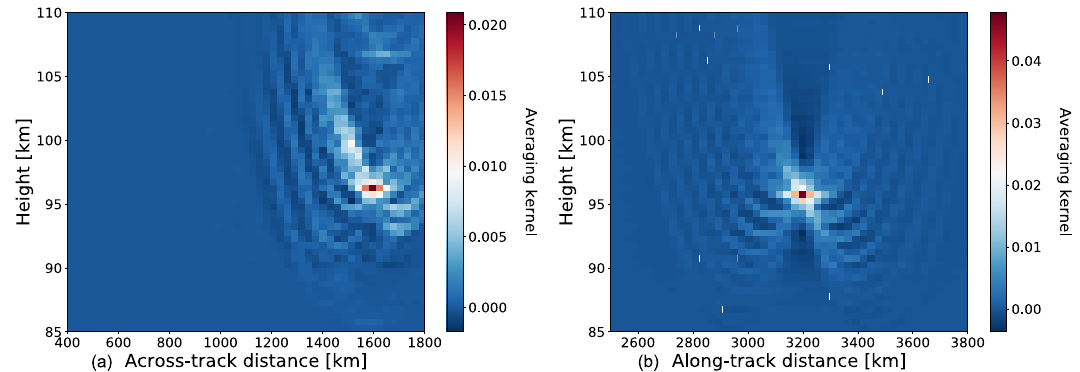
Figure 8. Averaging kernel matrix for retrieval points in the across-track slice (a) and along-track slice (b) . Panel (a) is for the point located at 96km vertically and 1600km across track, and (b) is for the points locating 96km vertically and 3200km along track.